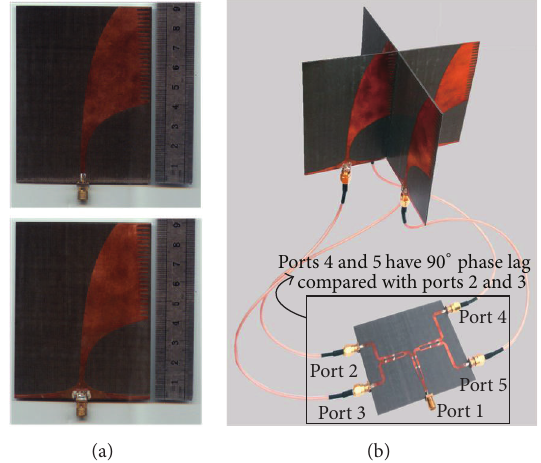
Figure 6: (a) Top and bottom views of the single antenna. (b) The photograph of the antenna